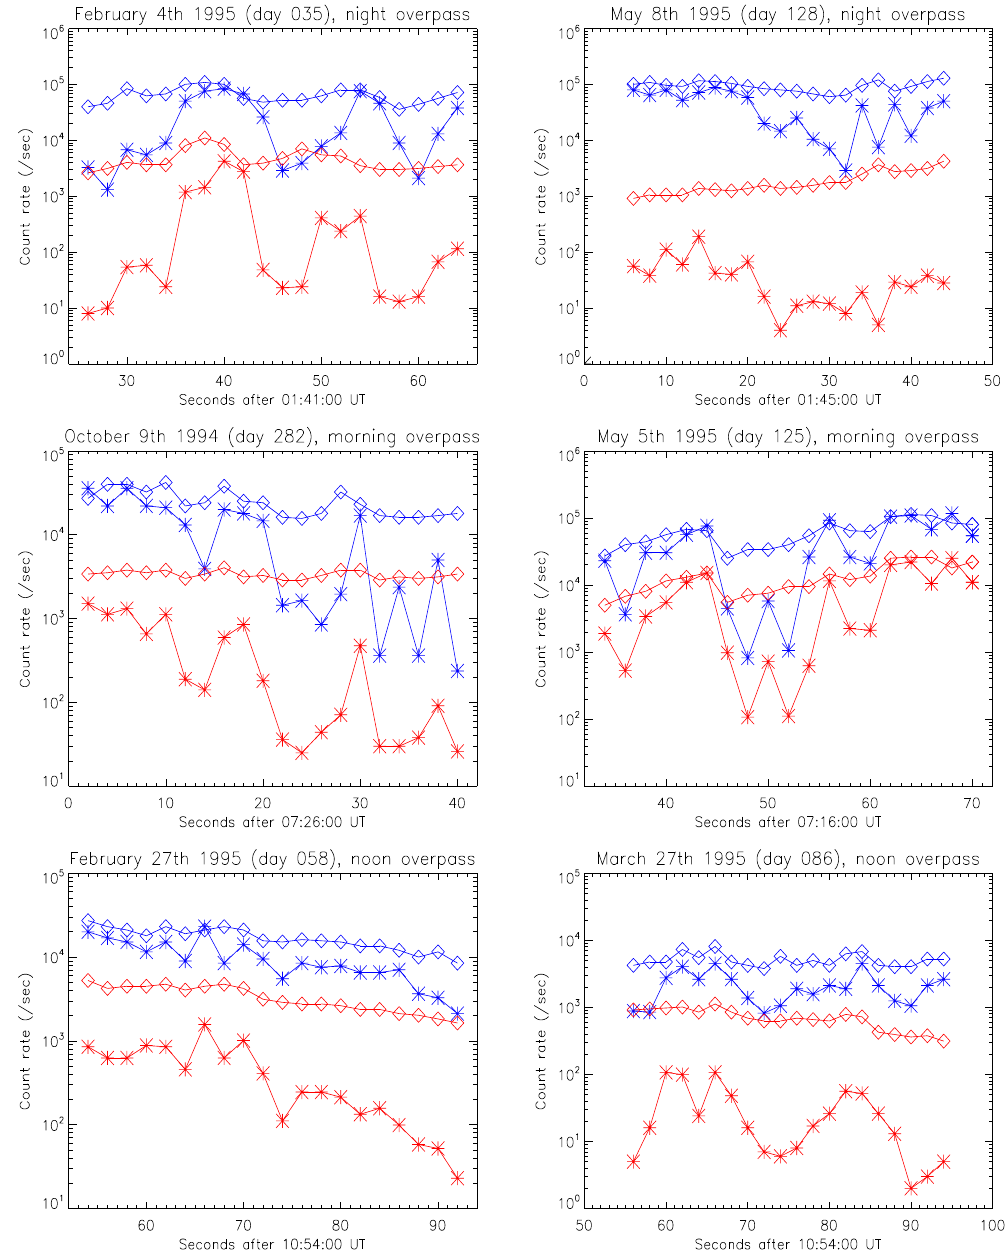
Figure 1: Variation with time of trapped and precipitated count rates (/sec) for both 30 keV and 100 keV Fig. 1. Variation with time of trapped and precipitated count rates (/s) for both 30keV and 100keV detector channels, for selected passes detector channels, for selected passes during night, morning, and noon (blue = 30 keV; red = 100 keV; asterisks during night, morning, and noon (blue=30keV; red=100keV; asterisks=precipitated; diamonds=trapped). = precipitated; diamonds = trapped). particles) and “ ≤ 10, > 10 to ≤ 100 or > 100” (for the